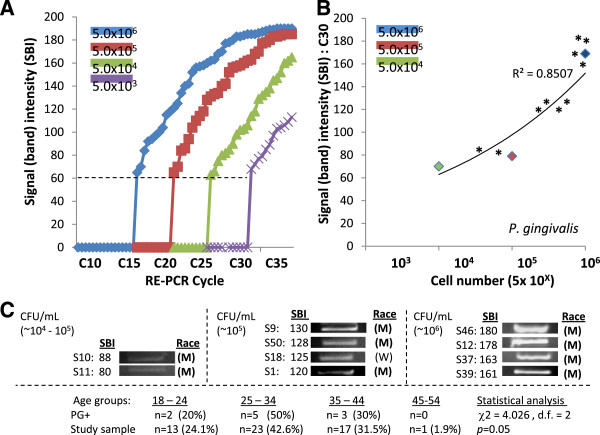
RE-PCR using DNA from P. gingivalis (PG) standards and saliva samples. A) DNA standards obtained from PG samples containing 5.0 x 103 - 106 CFU/mL established minimum threshold (CT) and saturation (CS) cycles; (high concentration) 5/0 x 106 CFU/mL CT = C15, CS = C35; (low) 5.0 x 136 CFU/mL , CT = C30, CS = 55. B) RE-PCR at C30 (at low concentration CT = C30, below high concentration CS = C35) revealed strong, positive correlations (R2 = 0.8507) between signal band intensity (SBI) and CFU/mL. C) RE-PCR using DNA extractions from all saliva samples revealed (n = 10/56 had elevated PG levels. Plotting the PG-positive sample SBI (*) with the DNA standards revealed samples with moderate to very high concentrations; Very high (n = 4), high risk (n = 4), moderate (n = 2). No significant differences in gender (not shown) between PG-positive and overall sample demographics were noted, however 90% (n = 9/10) of the PG-positive samples came from Minority patients, which was significantly different than in the overall sample (64.9%) (X2 = 17.921, d.f. = 1; p < 0.0001; M = minority, W = white). In addition, the ages of PG-positive patients were not found to significantly different than those of the study sample (p = 0.05).